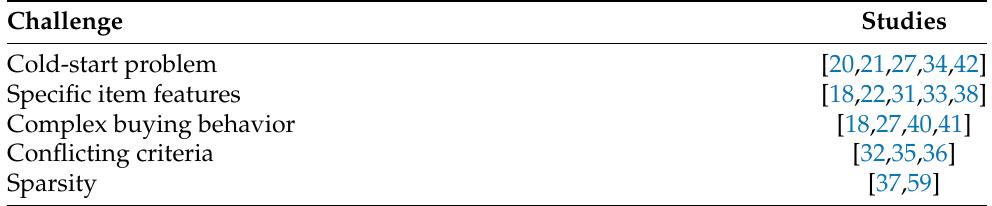
Table 3. Categorization of the papers based on challenges that they